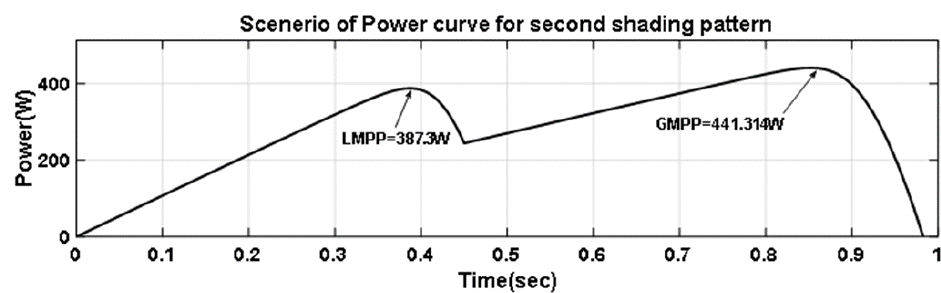
Figure 13. Power curve under second shading pattern like 1000 W/m 2 , 1000 W/m 2 , 500 W/m 2 and 500 W/m 2 .